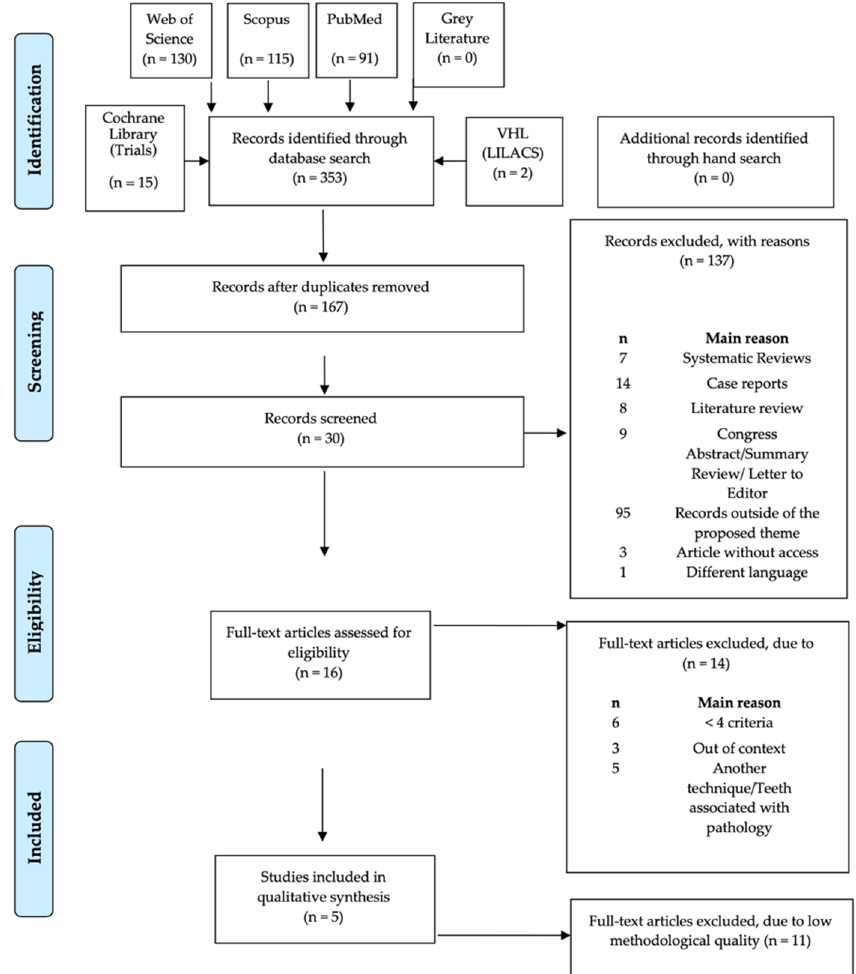
Figure 1. Preferred Reporting Items for Systematic Reviews and Meta-Analyses: Prisma 2009 Flow Diagram [14].